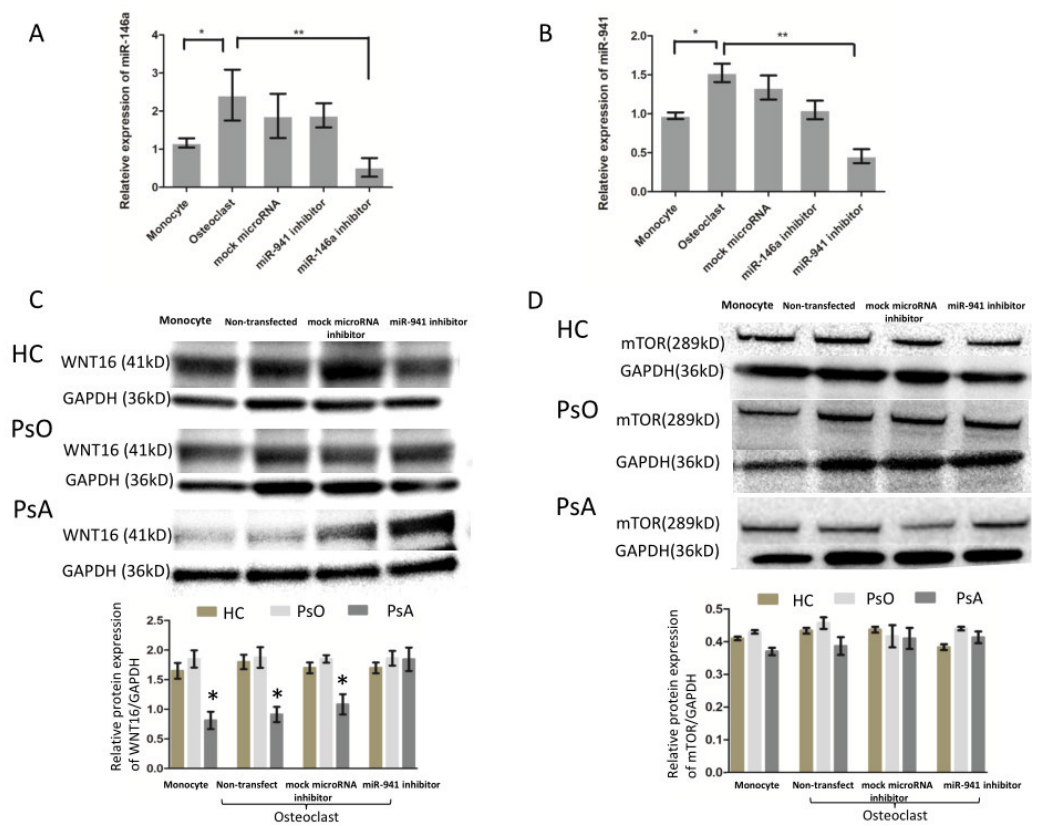
Figure 4. miR-941 inhibits osteoclastogenesis and negatively regulates WNT16 independent of miR-146a-5p. The CD14 + monocytes obtained from five PsA patients, five PsO patients, and five HCs were treated with medium only or subsequently activated into osteoclasts with treatment of M-CSF for 72 h. The cells with M-CSF treatment were either nontransfected or transfected with the control-microRNA inhibitor, miR-941 inhibitor or miR-146a-5p followed by TNF- α and RANKL every three days for nine days to study their ability to form osteoclasts and their activity of bone resorption. ( A , B ) At day 13, the expressions of miR-941 and miR-146a-5p in the monocytes and osteoclasts were measured by qRTPCR to evaluate the e ff ect of miR-941 and miR-146a-5p inhibitors transfection. ( C , D ) The protein expression of WNT16 and mTOR, the target genes of miR-941, were measured by western blot. * p < 0.05 and ** p < 0.01.